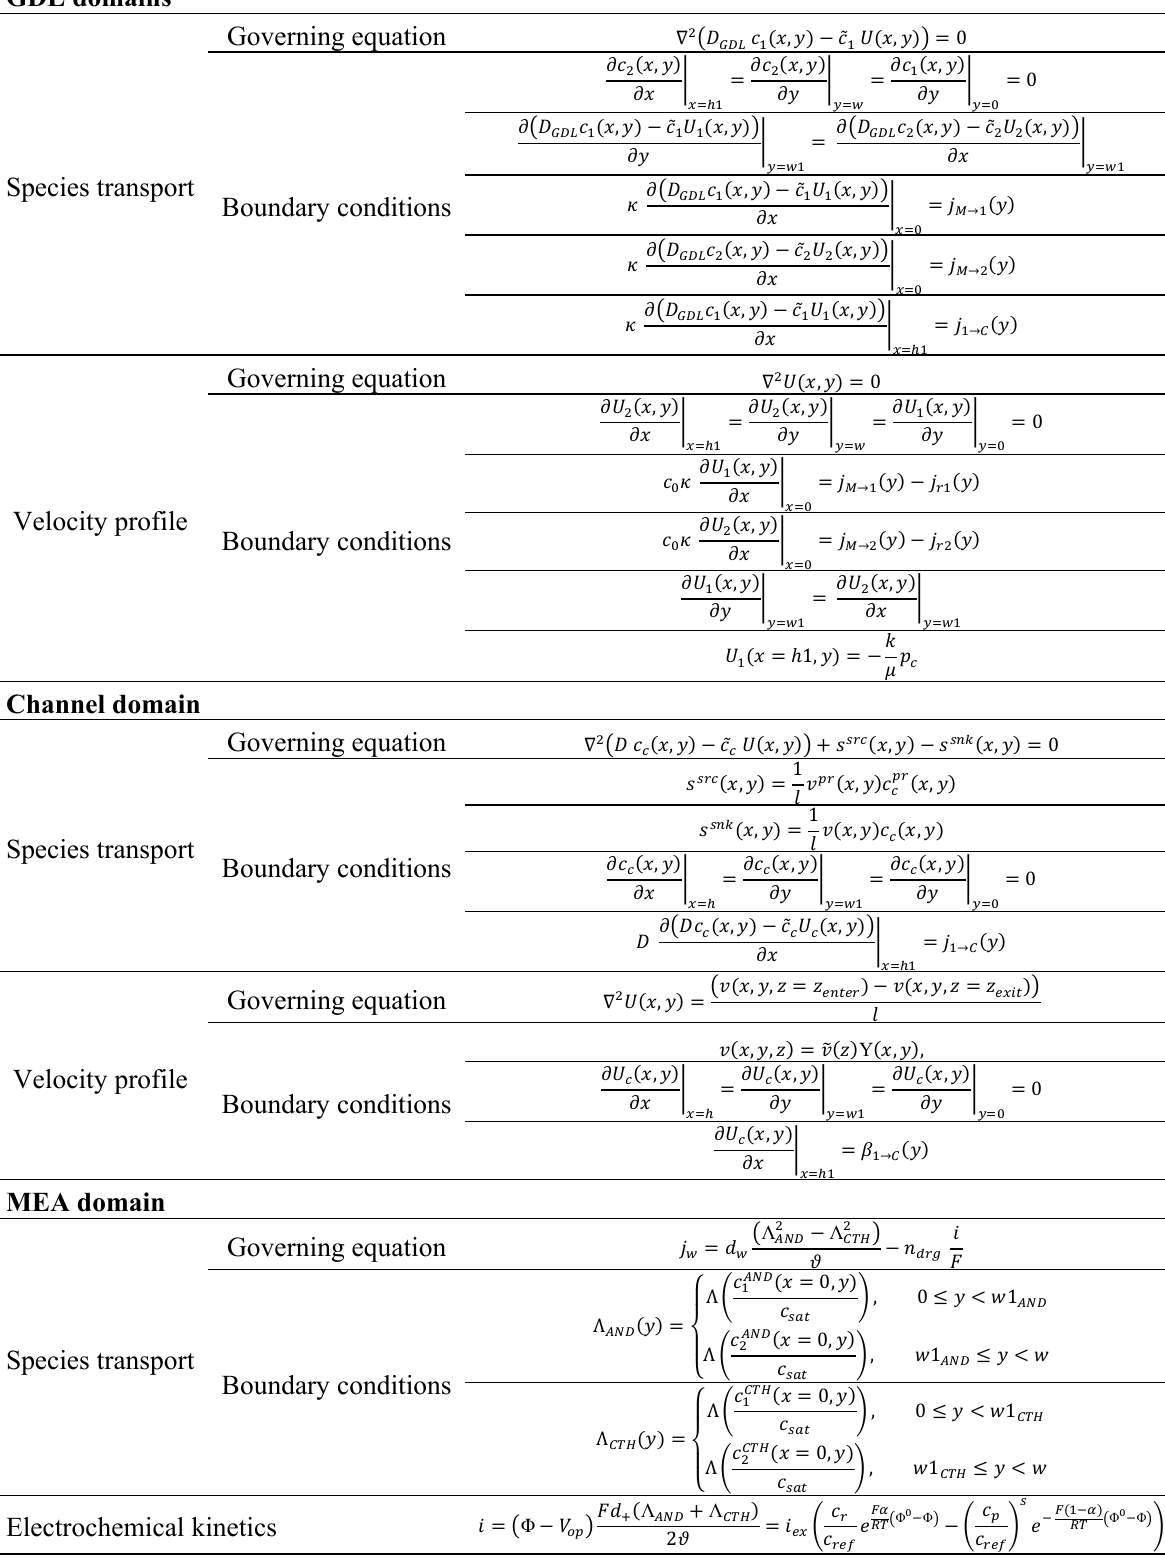
Table 1. Summary of key governing equations and their boundary